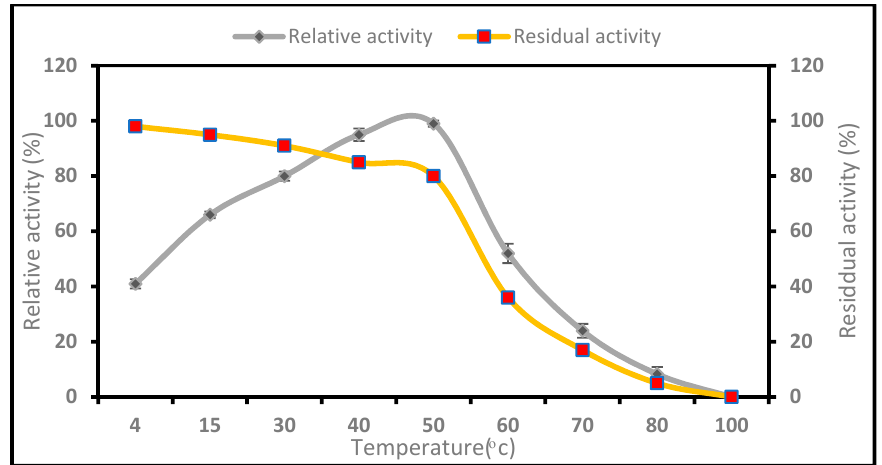
Figure 3. Effect of temperature on protease activity and stability. Error bars represent standard deviation of three replicates.